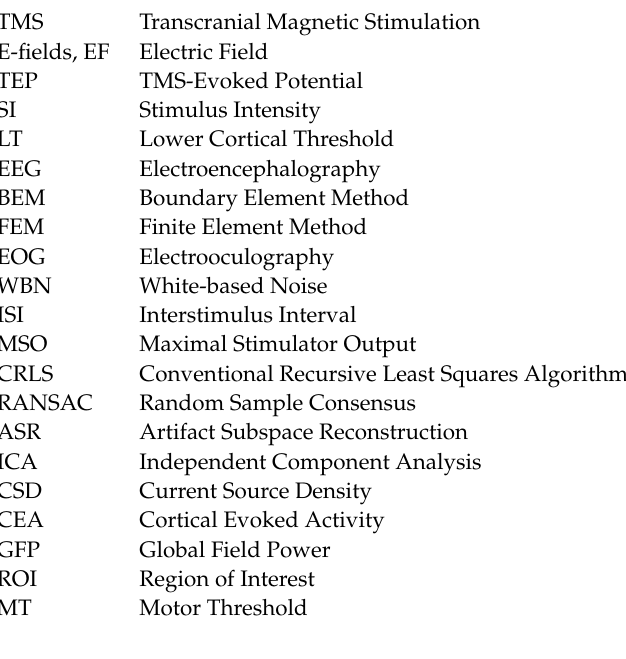
Figure S2: As Figure 6, but for linear fits; Table S1: Adjusted R 2 and statistical significance for the two CEAs and for individual subjects; Table S2: Adjusted R 2 for the two CEAs and for different model